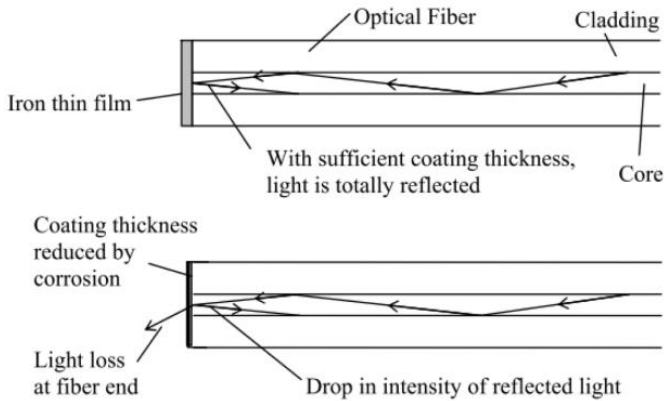
Figure 6. Change in intensity of light results in the detection of corrosion [85].